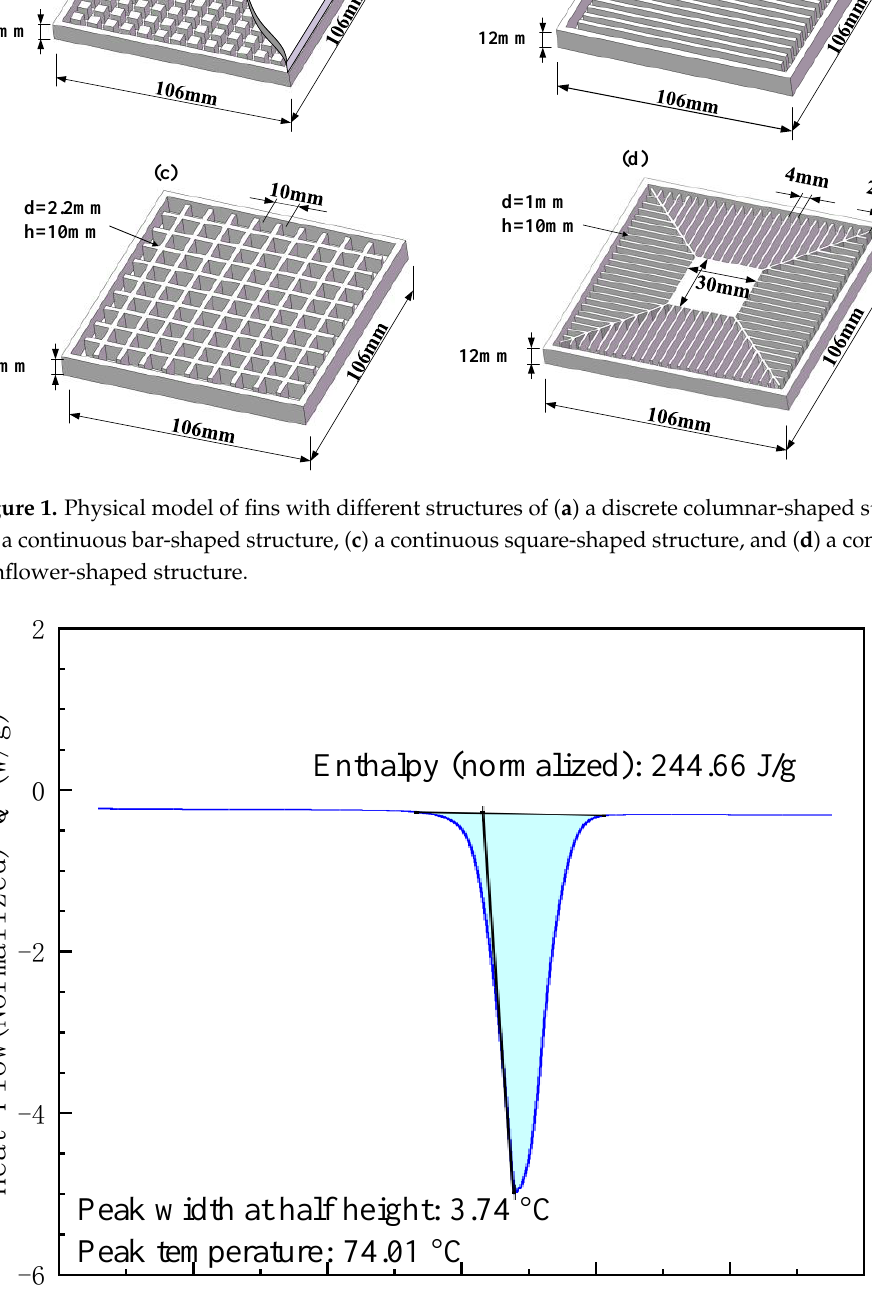
Figure 2. DSC curve of the paraffin wax.